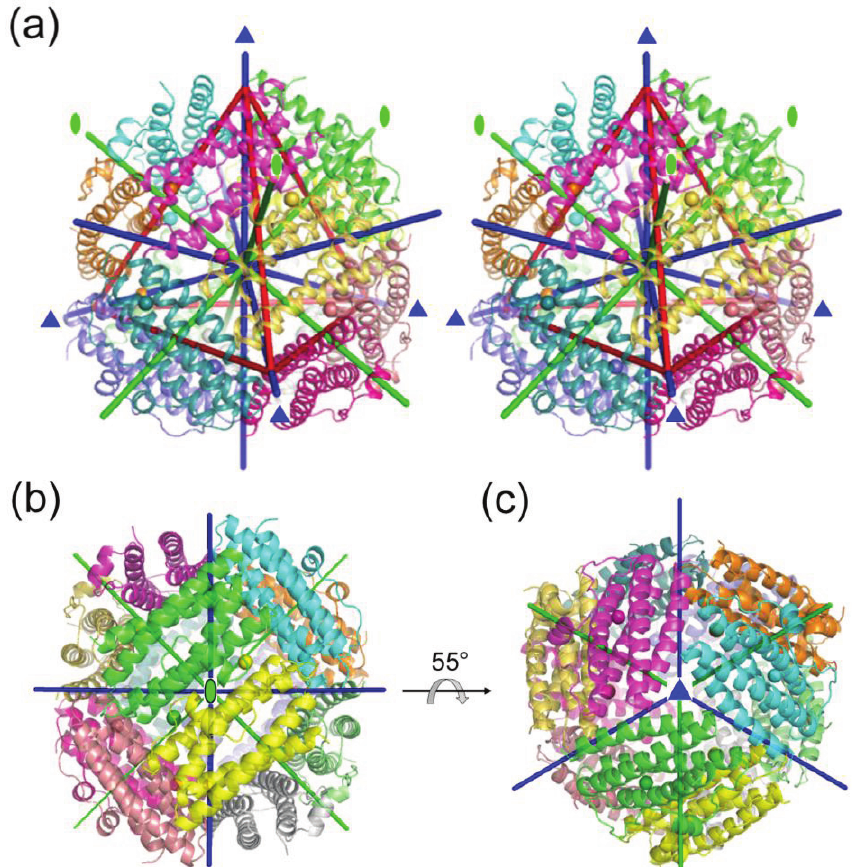
Figure 1. Overall structure of Fe-loaded HP-NAP YS39 (PDB ID: 3TA8). Each subunit with iron ions is shown in a different color. ( a ) Overall structure with a red tetrahedron to show the structure symmetry (stereoview). Green lines indicate two-fold axes, and blue lines indicate three-fold axes; ( b ) The view is from a two-fold axis; ( c ) The view is from one of three-fold axes.